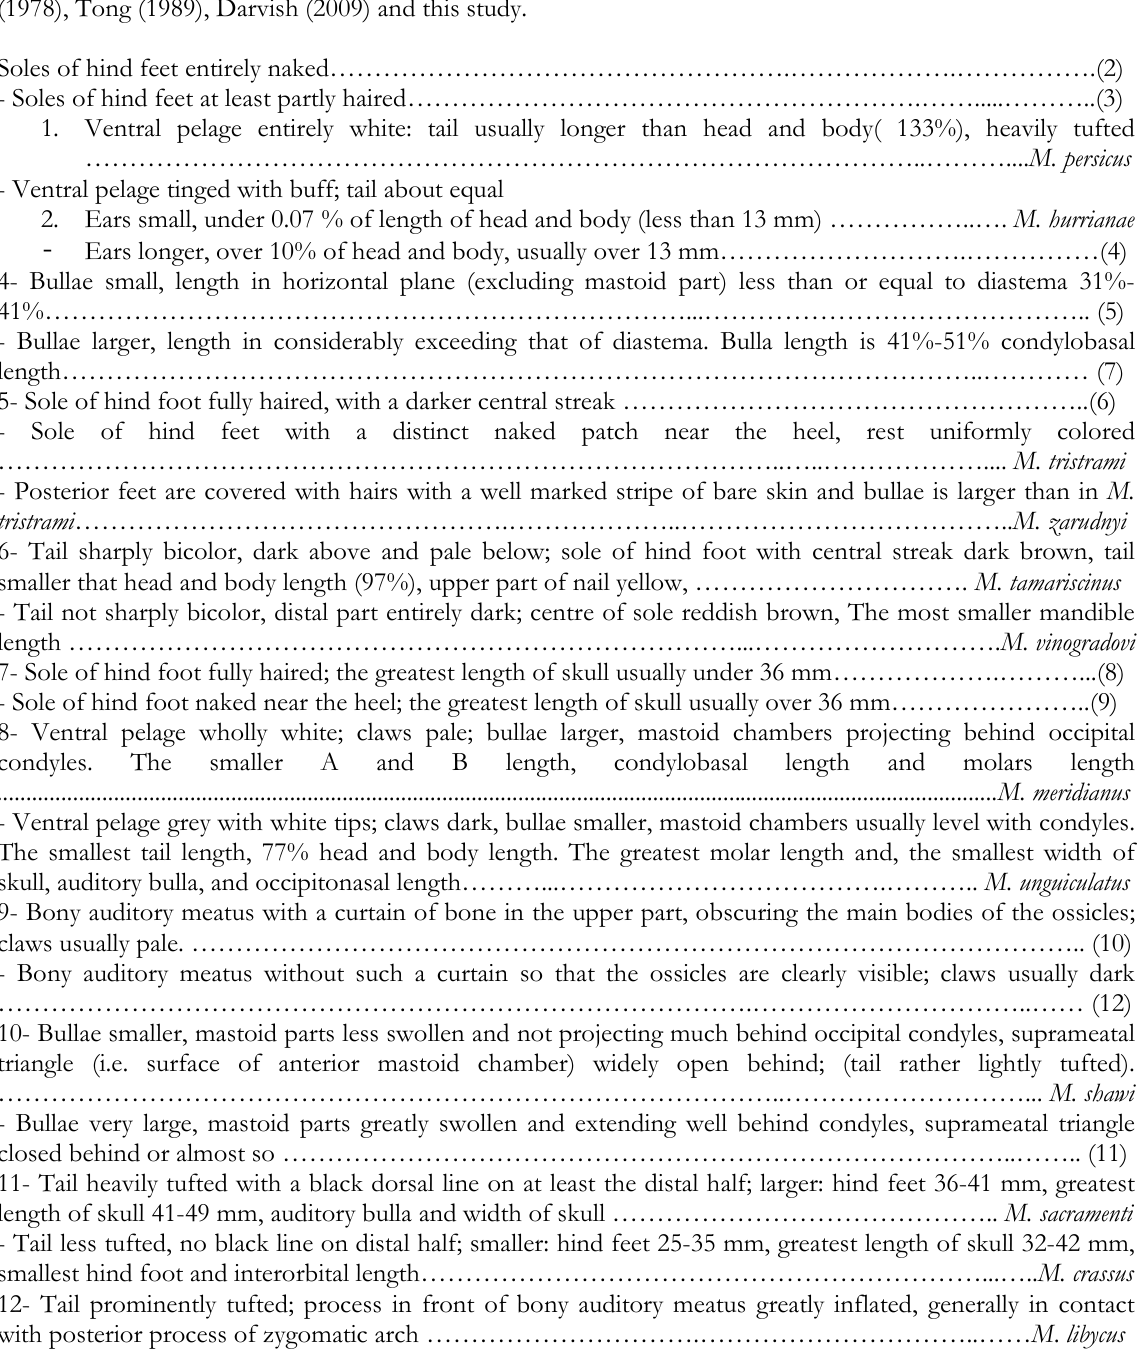
with posterior process of zygomatic arch ………………………….…………………………..…… M .